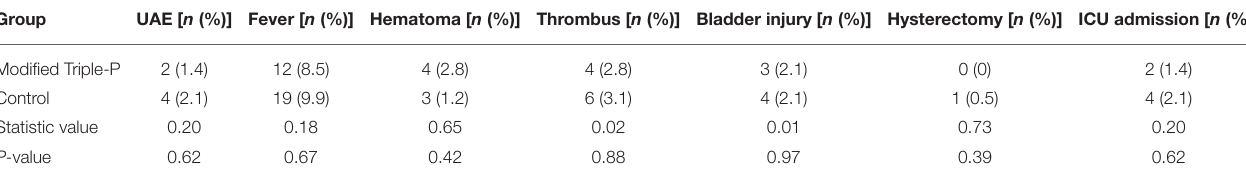
TABLE 3 | Comparation of postoperative follow-up data of the patients with placenta increta/percreta treated by two different procedures.